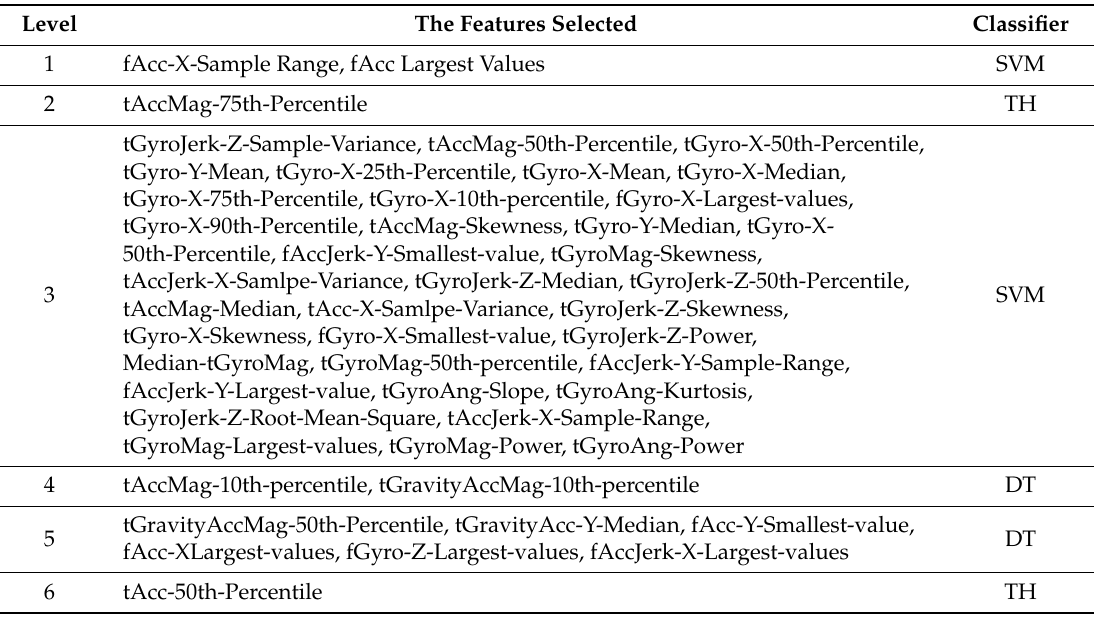
Table 14. Features selected and classifiers employed for each